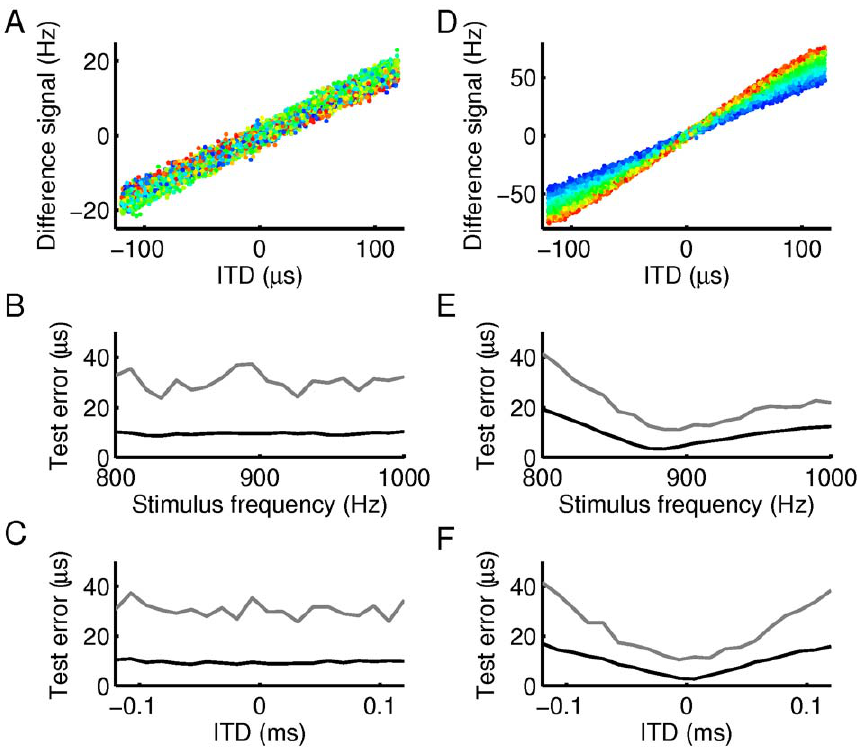
Figure 5. Bilateral difference coding. (A) Difference between the mean rate of the contralateral and the ipsilateral DNLL population. Colors indicate stimulus frequency from 800 Hz (blue) to 1000 Hz (red). (B) Test error as a function of frequency (black: root-mean-square error, grey: maximal error). (C) Test error as a function of of ITD (black: root-mean-square error, grey: maximal error). (D–F) Same as A-C where all neurons are simulated using the combination of CP and CD with highest mutual